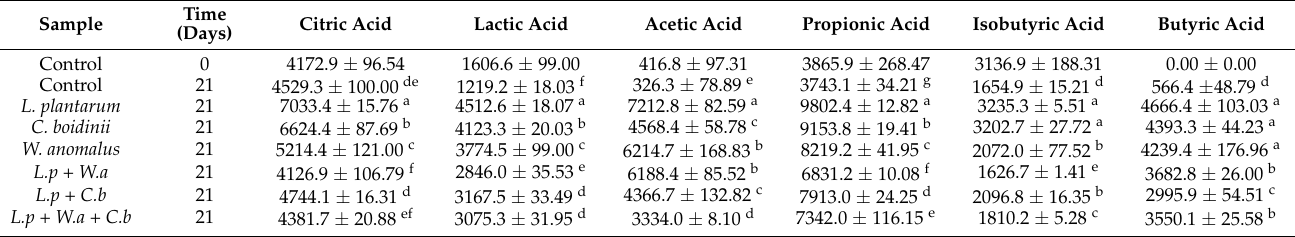
Table 2. Organic acids (mg/L) detected by